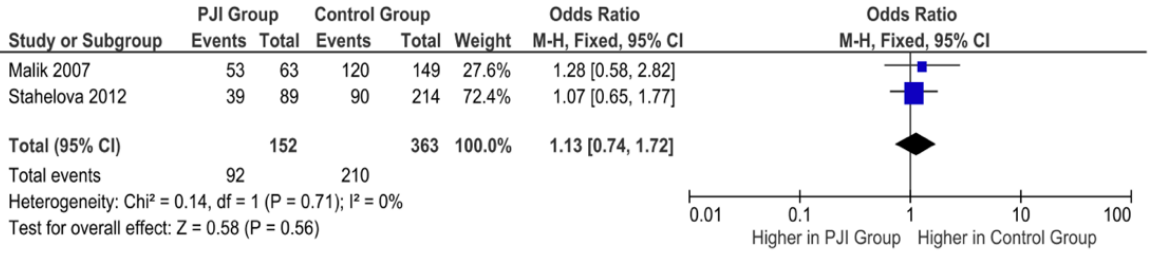
Figure 4. Forest plot indicating no significant association between the C allele polymorphism and the incidence of PJI following TJA.